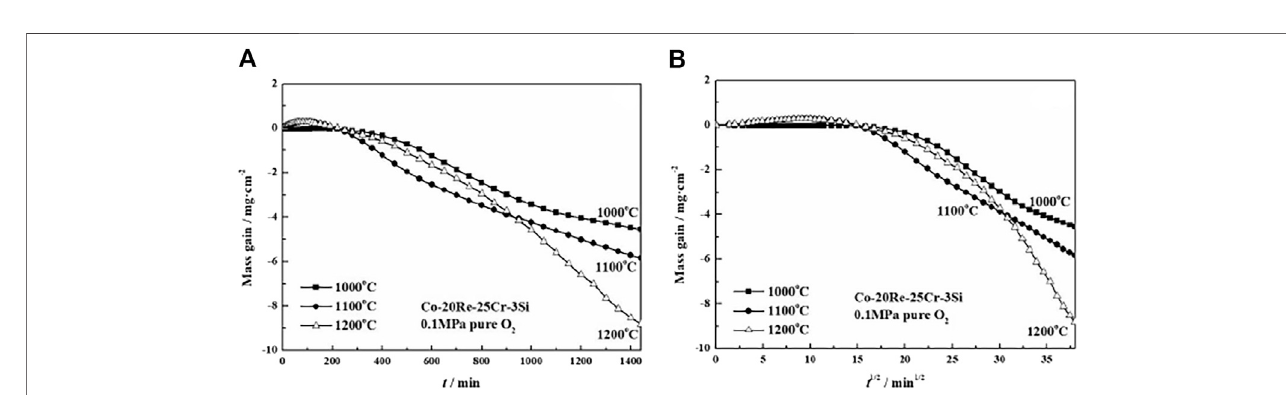
Figure 4 . By linearly fi tting a straight line, the slope and intercept of the line are the values of K T and C respectively.